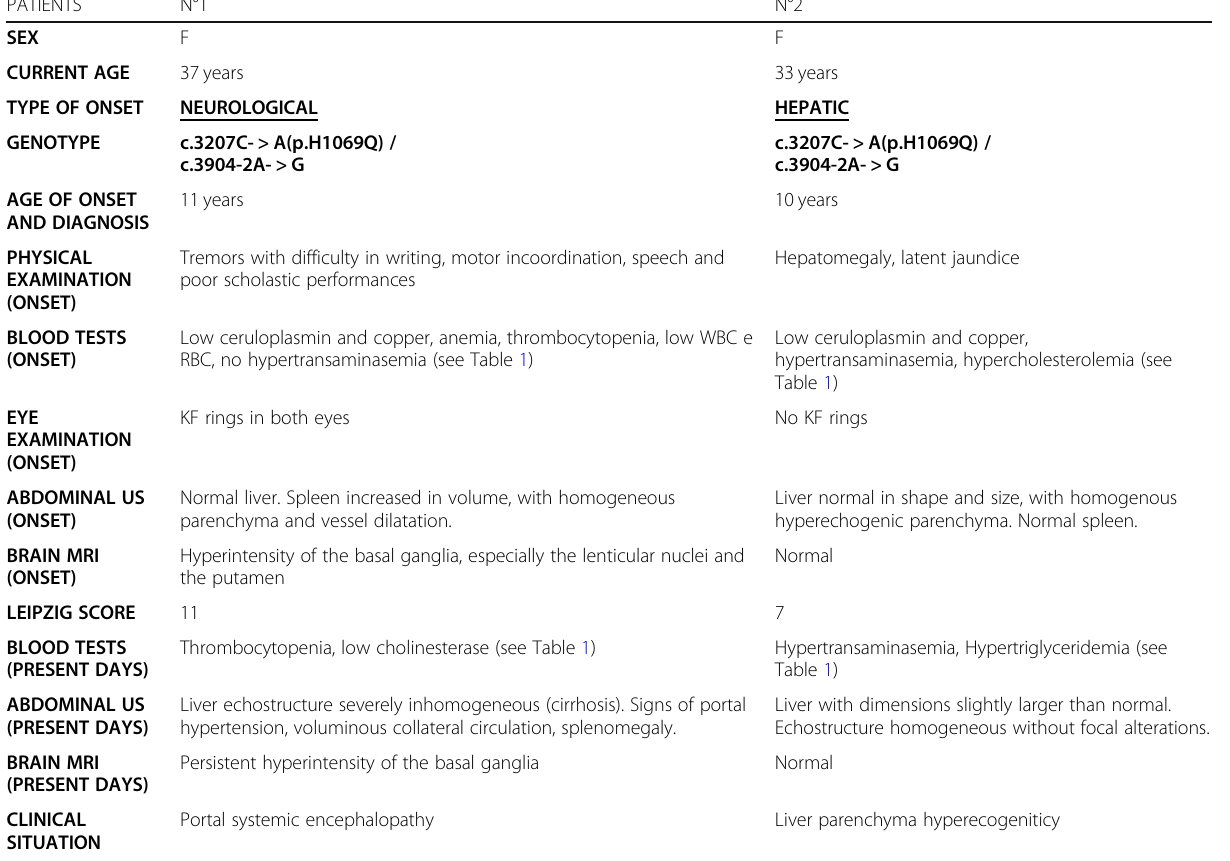
Table 2 Genotype-Phenotype comparison between the two patients of our study